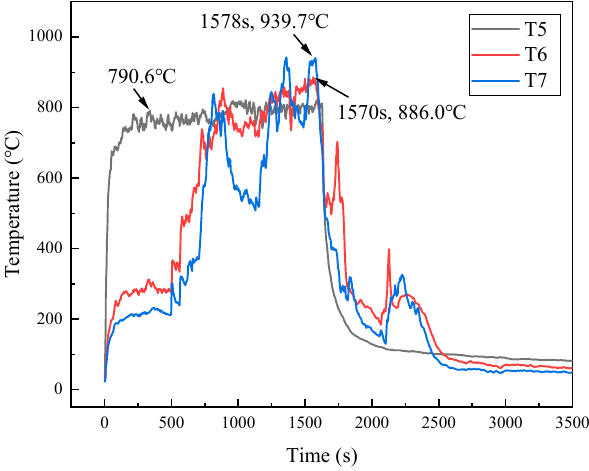
Figure 7. Flame temperatures above the safety valve and propane burner.